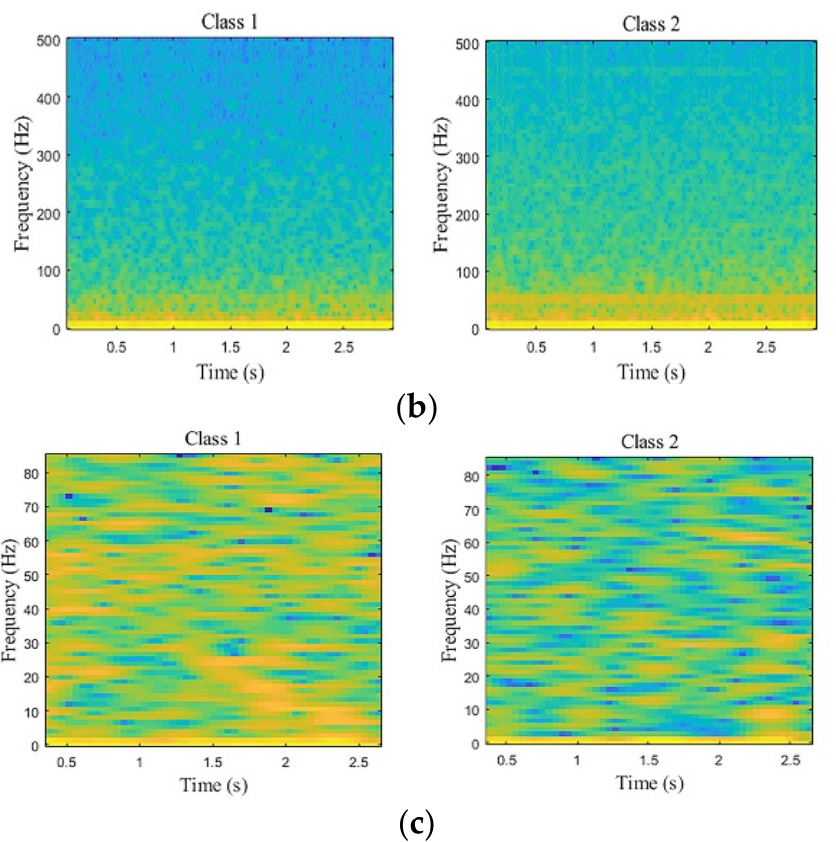
Figure 6. Visualizing representation learned by CNN model on the ECoG. ( a ) Raw signal during an average of all the samples in the same kind of MI tasks. Blue and orange traces illustrate two-class motor (left pinky and tongue), respectively. ( b ) Generated average spectrograms from raw filtered signals shown above. ( c ) Generated average spectrograms from deep representation.